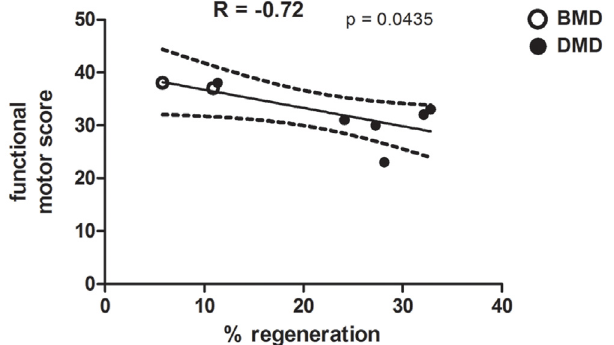
Fig 6. Correlation of the percentage of regenerating fibres with functional motor score in BMD and DMD. Correlation between functional motor score (assessment from a total score of 40) and the level of regeneration in quadriceps muscle from BMD (n = 2) and DMD (n = 6) patients. Dashed lines show 95% confidence